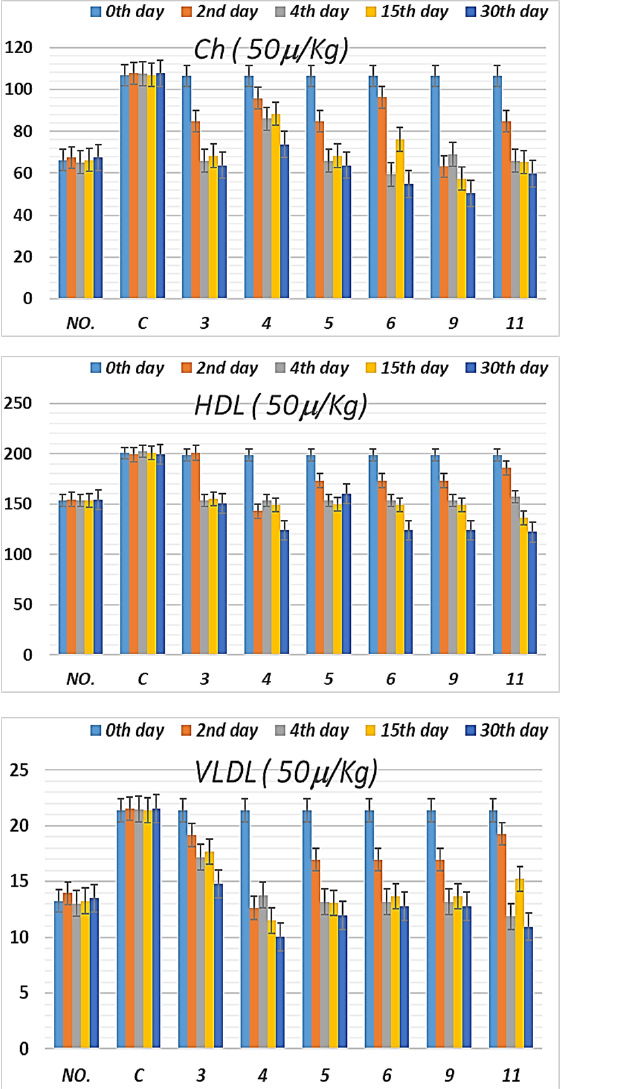
Figure 7. The level of Ch (cholesterol), TG (triglyceride), HDL (high density lipoprotein), LDL (low density lipoprotein) and VLDL (very low density lipoprotein) in serum of hyperglycemic loaded rats. 50 (µ/Kg) on 0th day (pre-drug values), 2nd and 4th day (Post-drug values) for each group of compounds ( 3–6,9, and 11 ) and control. Data analyzed by one way ANOVA followed by LSD test and expressed as mean ± SEM from five observations.